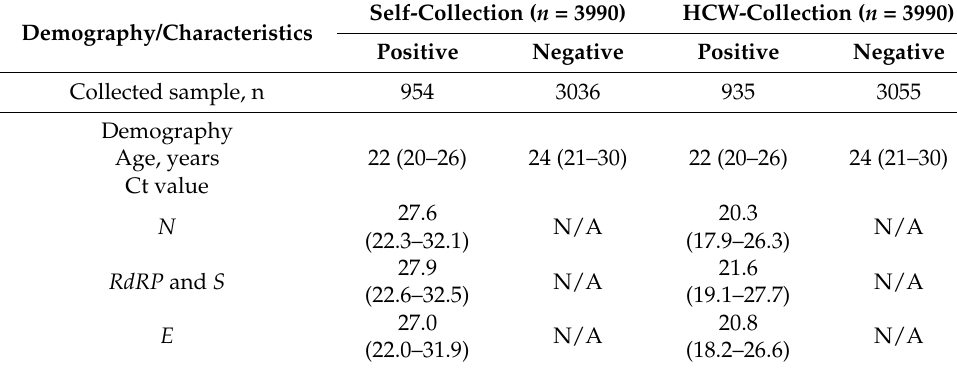
Table 1. Demography and characteristics of the study participants.